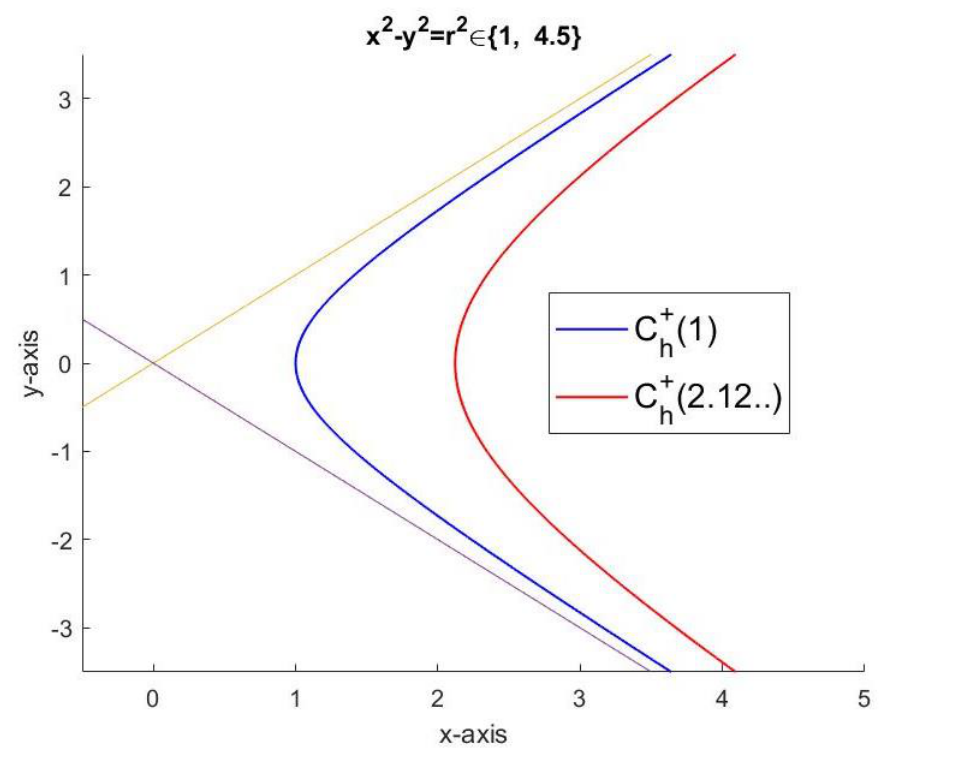
Figure 1. Hyperbolic half − circles in the event space X